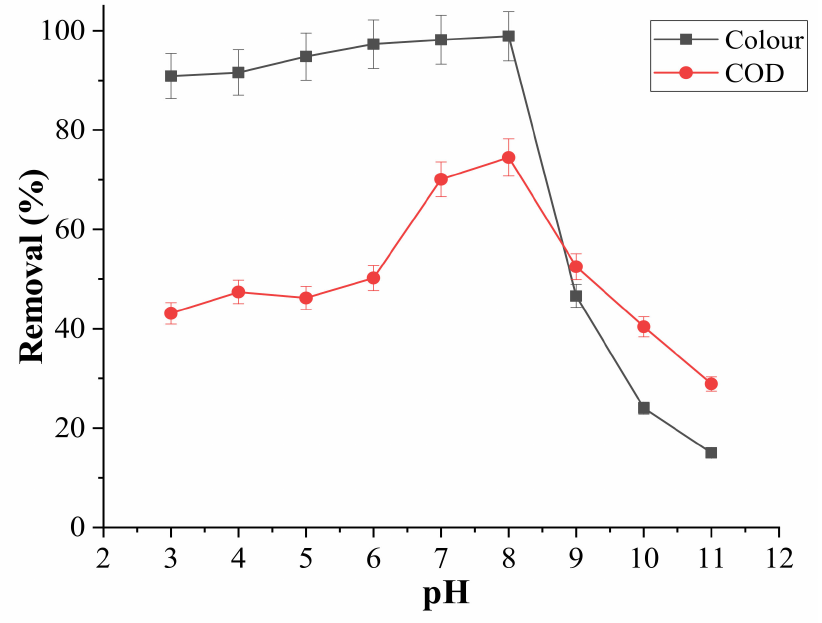
Figure 1. Influence of pH on the removal of colour and COD using SnCl 4 (10,000